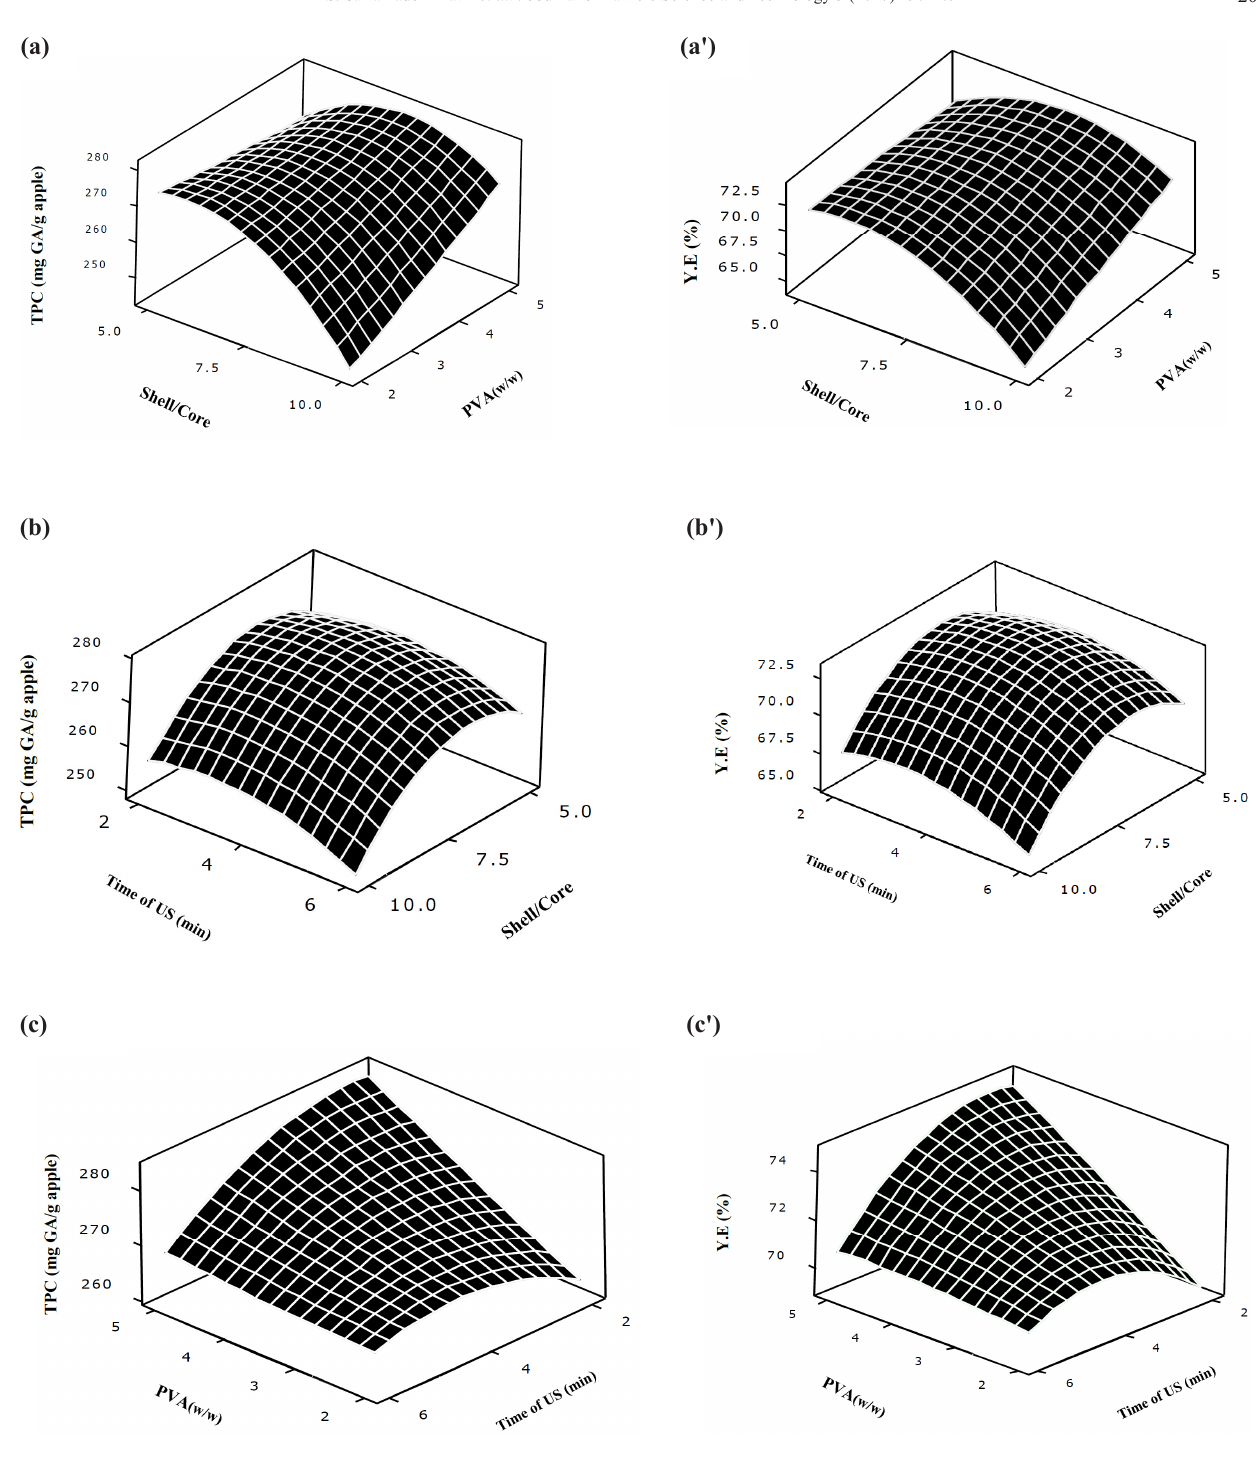
Fig. 2. Response surface plots of the combined effect of shell-to-core ratio and surfactant (PVA) concentration (a), shell-to-core ratio and time of sonication (b), PVA concentration and time of sonication (c) on the TPC of loaded NPs, shell-to-core ratio and PVA concentration (a'), shell-to-core ratio and time of ultrasonication (b'), PVA concentration and time of sonication (c') on the yield of NPs